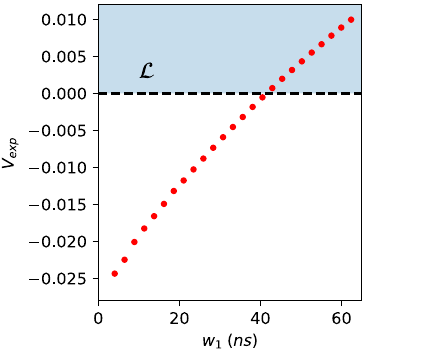
Fig.8|Robustnessofthein fl ationinequalitytoexperimentalnoise. Inthisplot, we showthe achievedvaluefortheinequalityfrom in fl ationtechnique, asfunction of the two-fold coincidence window w 1 . As expected, since this increases uncor- related 2-fold events, the measured correlations become “ local" for large enough windows. The leftmost point corresponds to the result reported in subsection “ Bounding measurement dependence and violating an entropic inequality for the triangle network", i.e., a window w 1 ~4.1ns, the plotted error bars are calculated throughMonteCarlotechniqueassumingPoissonianstatisticsandaresmallerthan the size of the points. The blue shadowed region L indicates the values obtainable by a classical causal model.